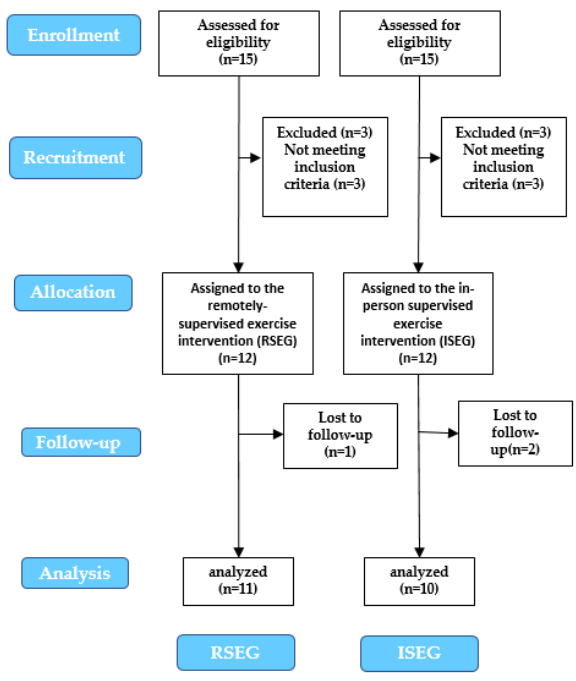
Figure 2. Flow Diagram of The Two Multi-Component Interventions.